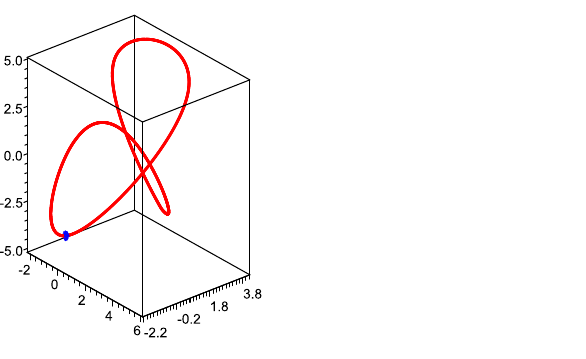
Figure 3. The value of κ max = 1.652746390 is attained at the blue point on C L